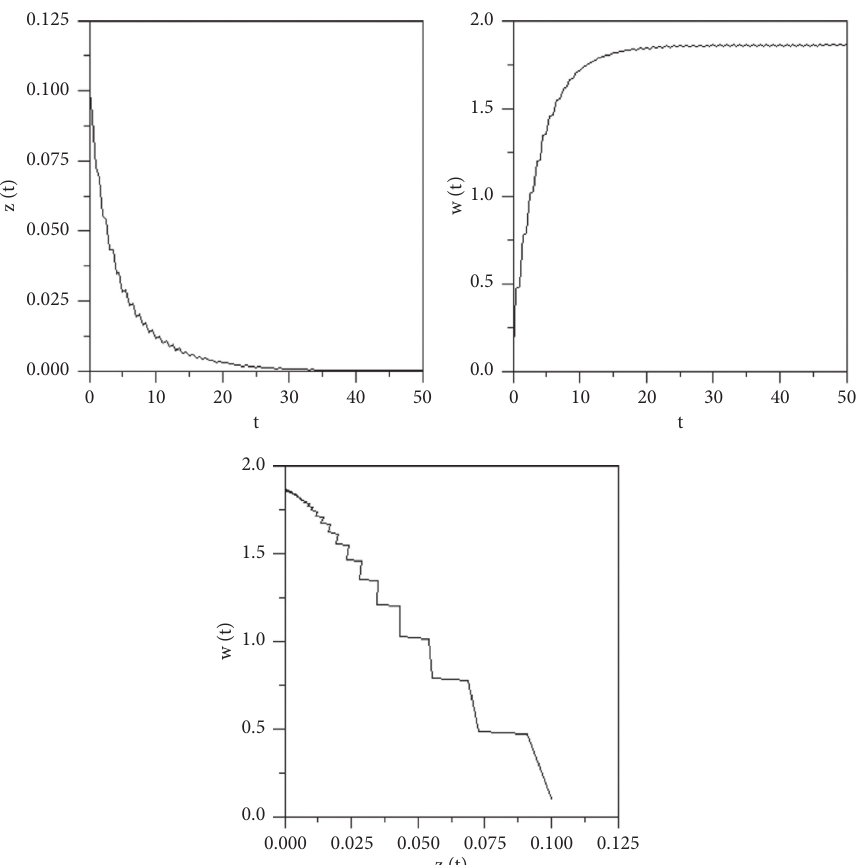
� 0 . 98 , b � 0 . 68 ,b � 0 . 25 ,b 1 2 3 4